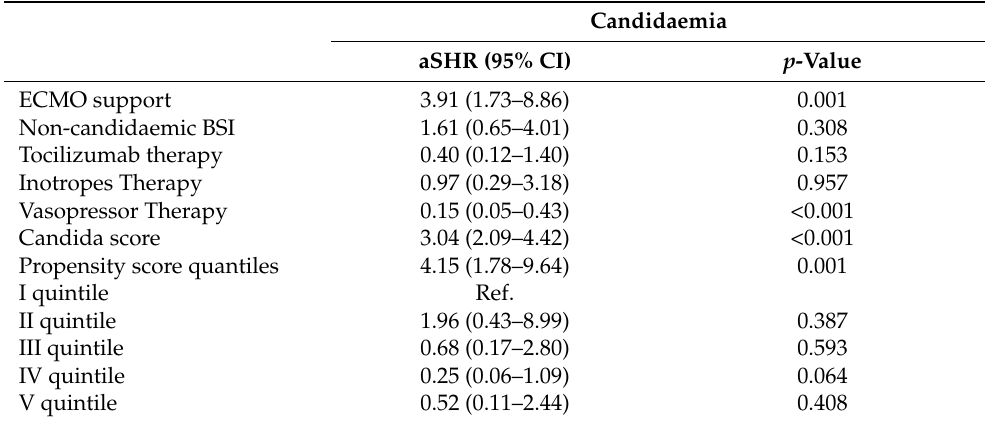
Figure 1. Cumulative incidence function for candidaemia among the patients admitted to the intensive care unit of Umberto I teaching hospital of Rome between March 2020 and June 2021 and who underwent IOT and mechanical ventilation. Table 3. Multivariable competing risk Fine-Gray regression models for candidaemia (among the patients admitted to the intensive care unit of Umberto I teaching hospital of Rome between March 2020 and June 2021 and who underwent IOT and mechanical